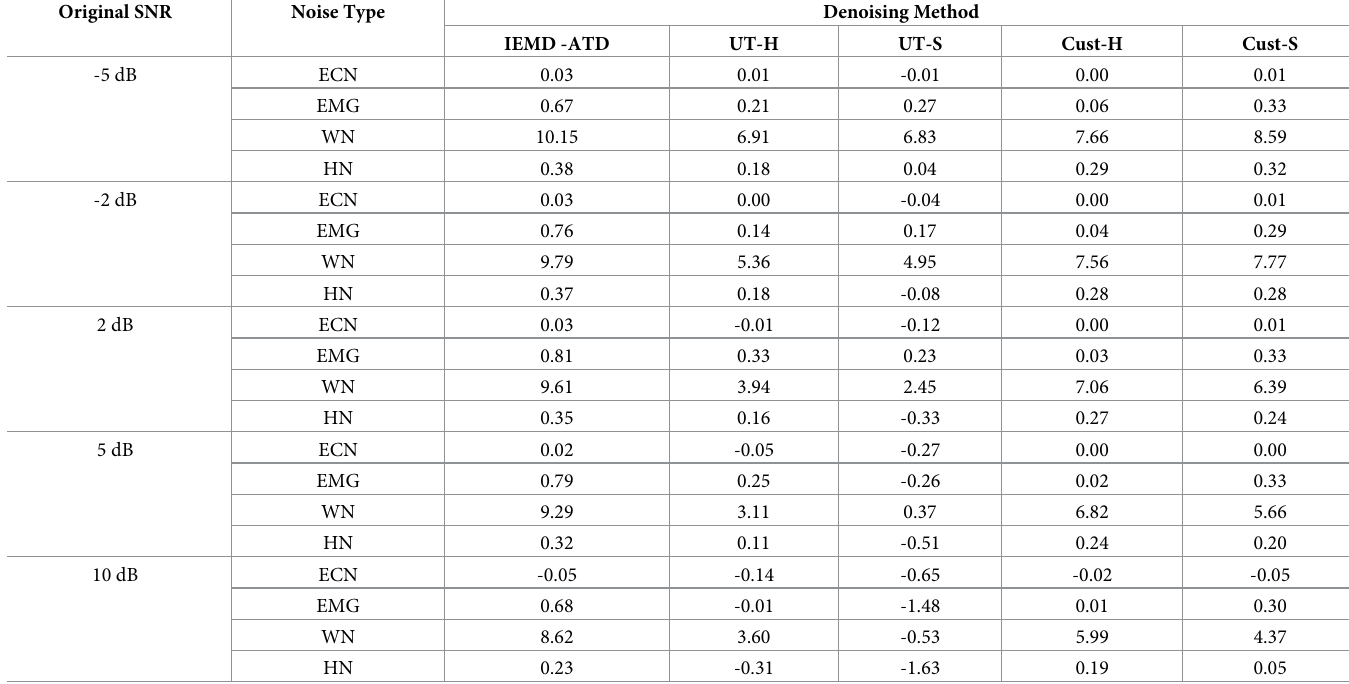
Table 14. Average SNR improvement of 10 real ECGs for eliminating only high-frequency